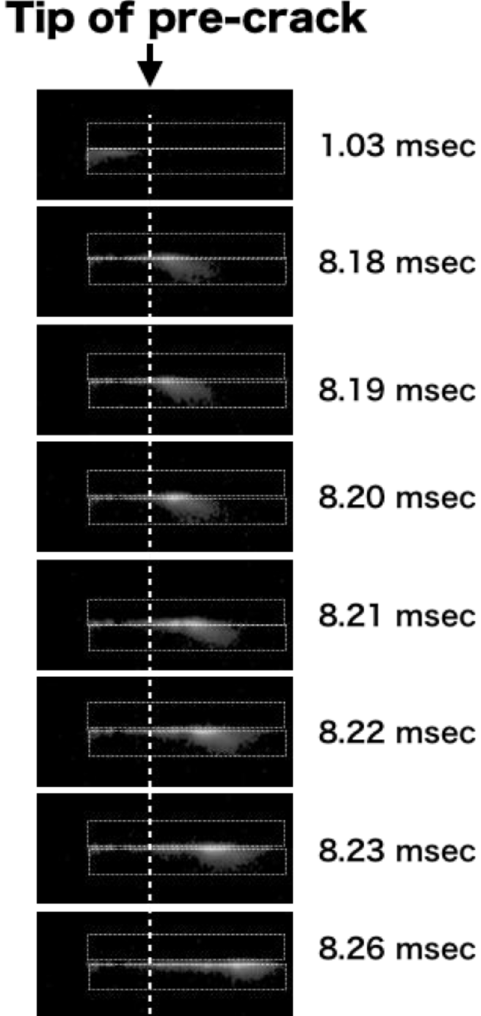
Fig. 13. ML experiments with high-speed camera to visualize the stress concentration at the crack tip. The upper part is Al and the lower part is